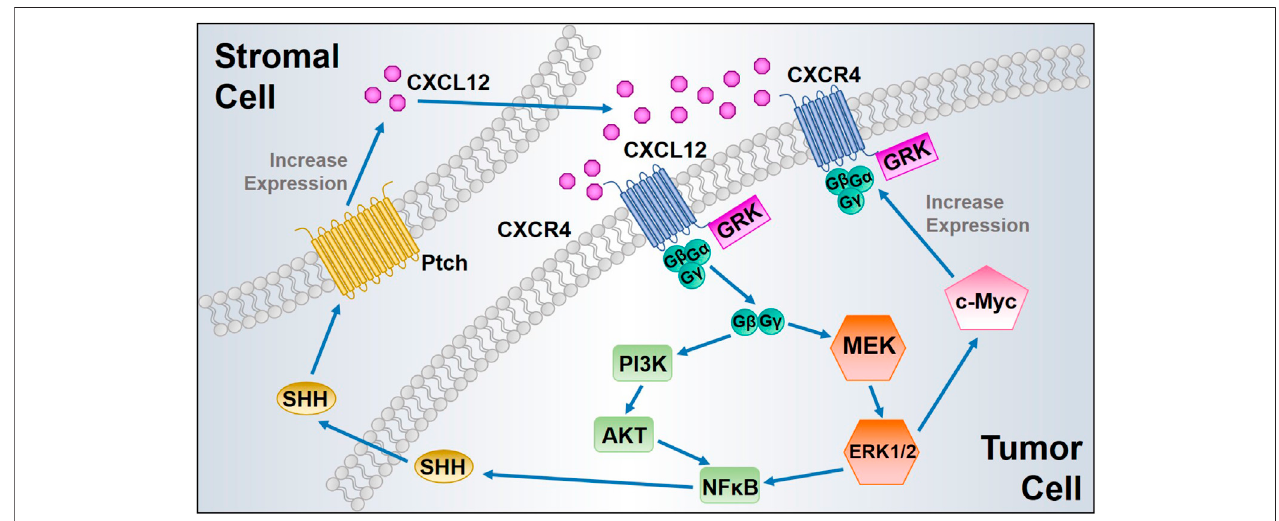
FIGURE 2 | Proposed positive feedback loops of CXCL12/CXCR4 signaling to enhance tumor cell proliferation. ERK1/2 MAPK activated by CXCL12/CXCR4 interaction induces c-Myc signaling, leading to CXCR4 upregulation with increased cancer cell proliferation. In addition, CXCL12 binding to CXCR4 triggers NF κ B signaling, which induces SHH synthesis and release from the tumor cells. Secreted SHH promotes CXCL12 upregulation and release from the stromal cells after its binding to protein patched homolog (Ptch), which in turn activates CXCL12/CXCR4 axis in tumor